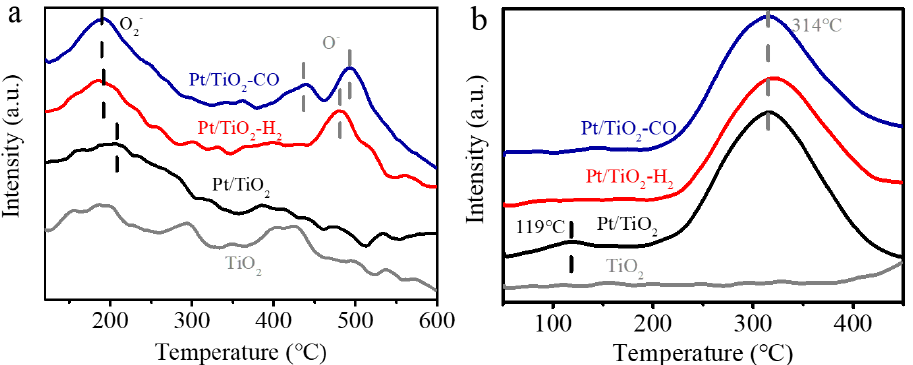
Figure 3. ( a ) O 2 -TPD and ( b ) H 2 -TPR profiles of Pt/TiO 2 , Pt/TiO 2 -H 2 , and Pt/TiO 2 -CO catalysts.